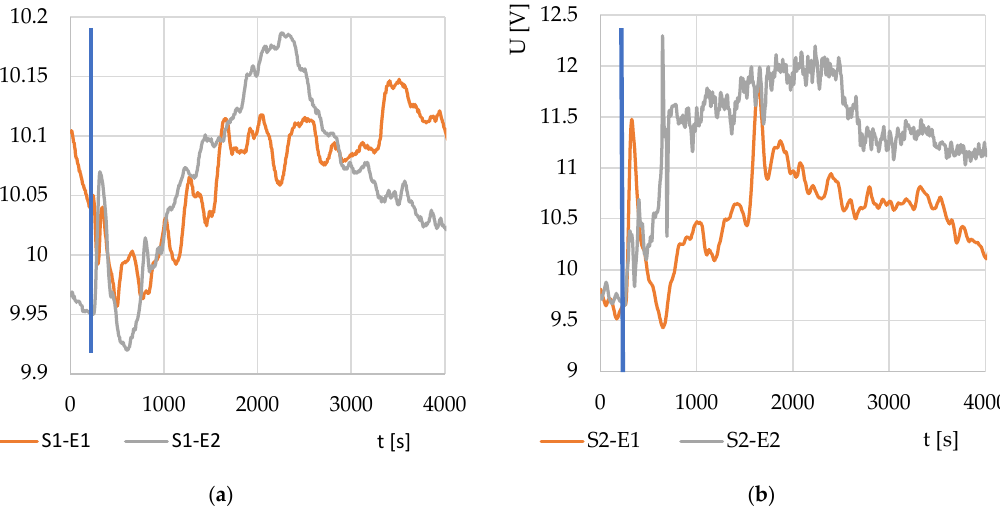
Figure 3. Testing of the device on a model solution of yeast (1 g) in water (150 mL) with beet sugar (2.5 g) for ( a ) thermodynamic system S1 and ( b ) thermodynamic system S2. The experiment was performed twice (E1 and E2).